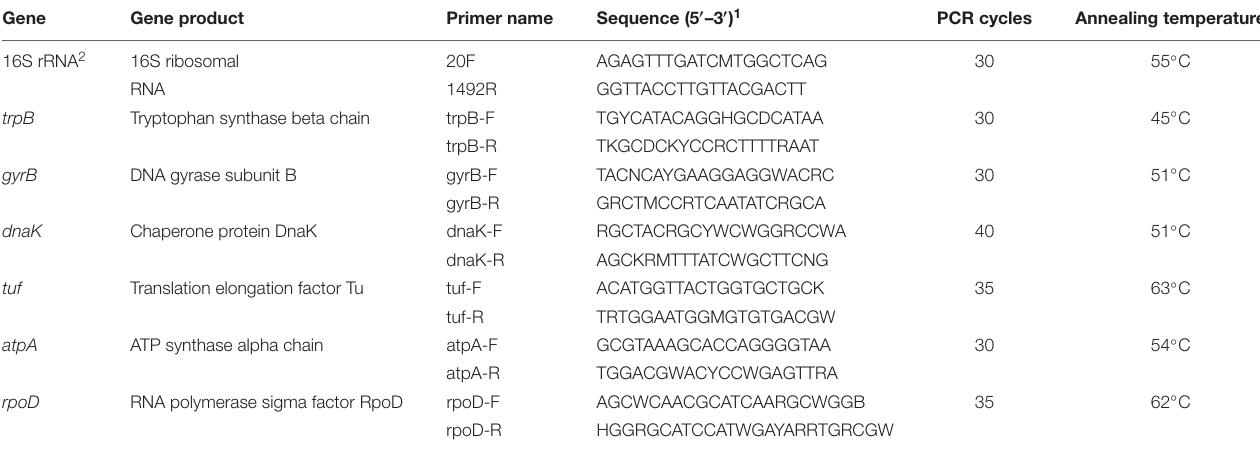
TABLE 4 | Sequences of primers designed for the amplification of Flavobacterium columnare housekeeping genes used for the MLSA and corresponding PCR cycling parameters. Gene Gene product